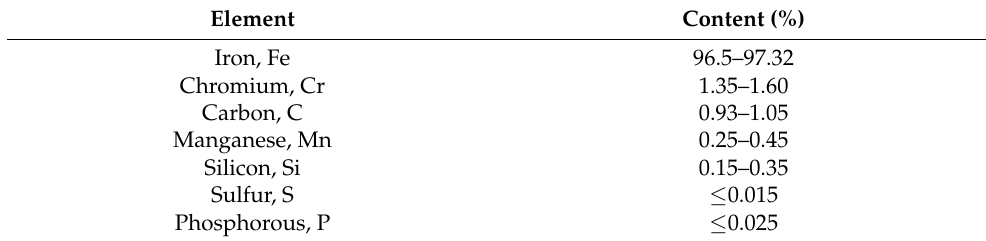
Table 1. Chemical composition of SAE 52100 alloy steel [25].